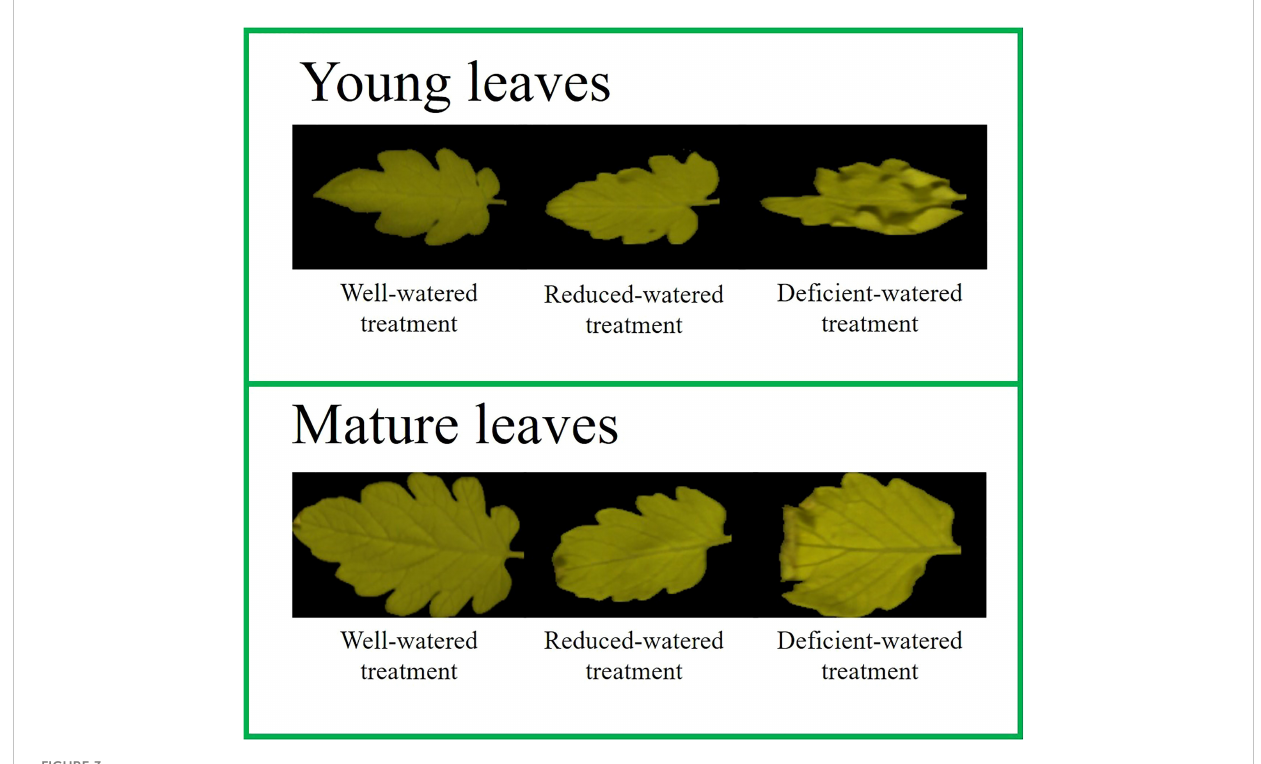
FIGURE 3 Color composite images of tomato leaves under different water